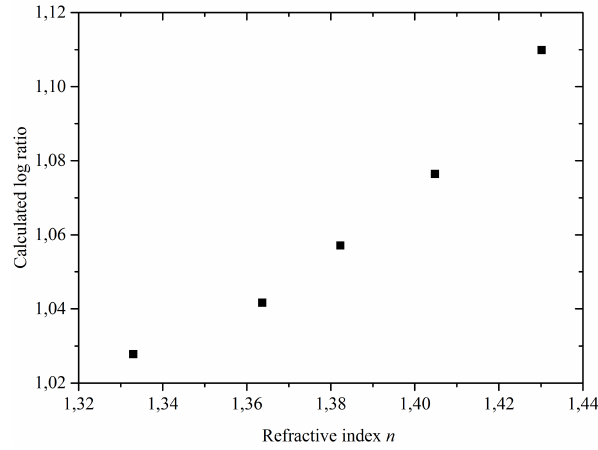
Figure 9. Calculated WSPD-measuring characteristics for the nor- malized reflection spectra from Fig.